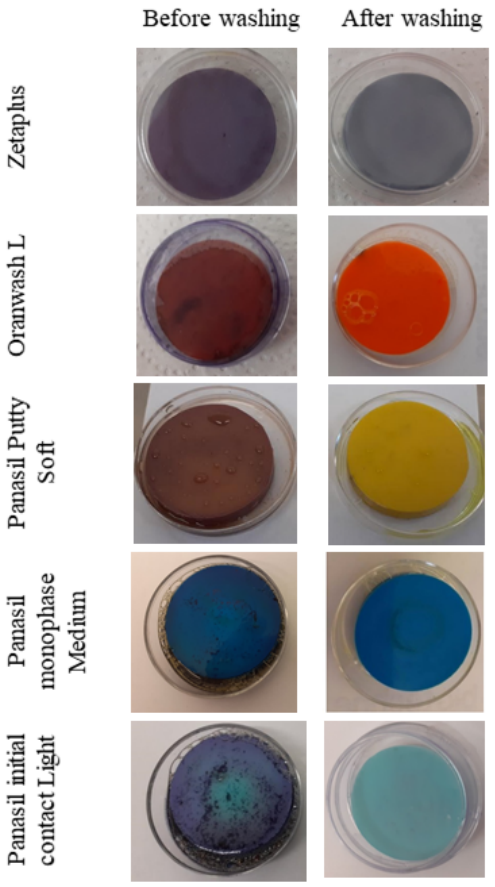
Figure 1. Validation of the effectiveness of washing away of cells adhered to the contaminated samples by immersion with PBS and vortexing. Before washing away, the presence of viable cells (a mixture of the oral pathogens: S. aureus, P. aeruginosa, and C. albicans ) was demonstrated on the surface of all the dental impression materials studied. After washing, detachment of the cells was